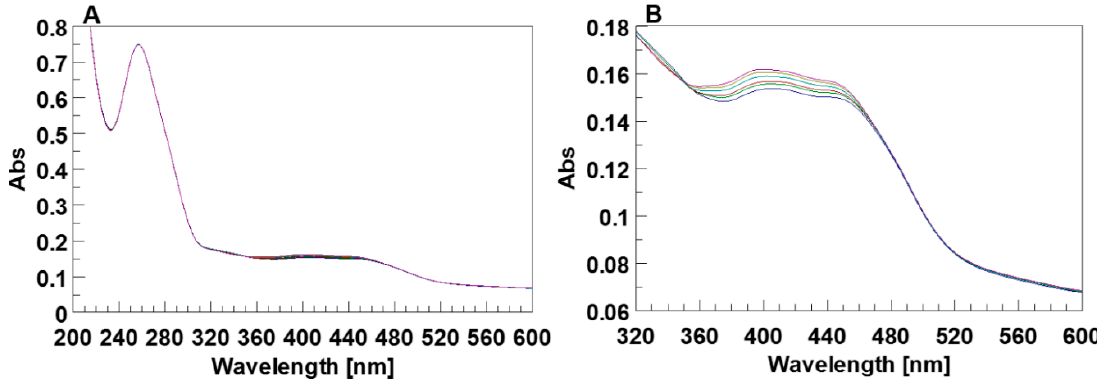
Figure 10. ( A ) Time-dependent UV spectrum of the 5 (cid:48) -DMAzo-TBA in the 5KEW-TEA blend; after irradiation at 436 nm. ( B ) The enlargement of the UV-vis region between 320–600 nm. The band intensities around 440 nm attributable to the absorption of the conjugated 5 (cid:48) DMAB slightly decrease after irradiation (blue line), and consecutively increases over time to reach the values observed before irradiation (violet line) in dark. [ON] = 3.5 × 10 − 6